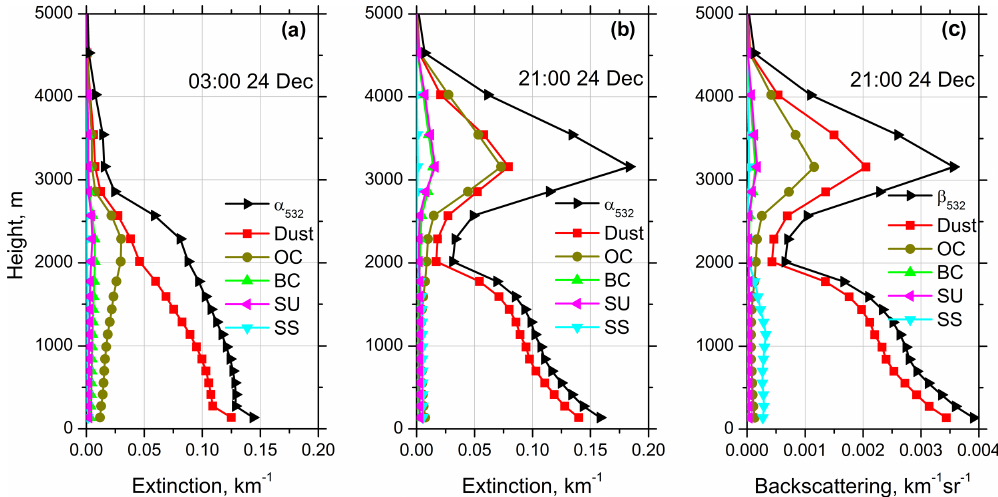
Figure 12. Vertical profiles of extinction coefficients at (a) 03:00UTC, (b) 21:00UTC and (c) backscattering coefficients at 21:00UTC on 24 December 2015 from MERRA-2 model at 532nm. Profiles are given for five aerosol components: dust, black carbon (BC), organic carbon (OC), sea salt (SS), and sulfates (SU), together with total extinction α 532 and backscattering β 532 .